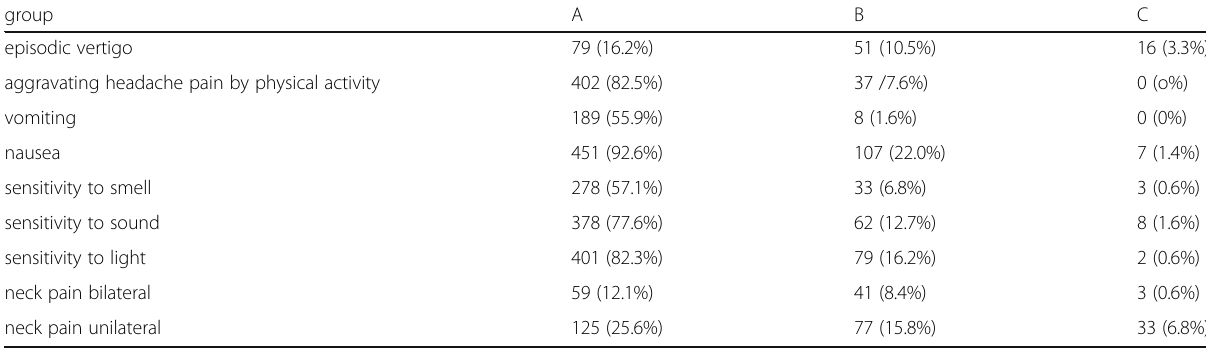
Table 1 Number of migraine associated symptoms in different groups ( n = 487) group A episodic